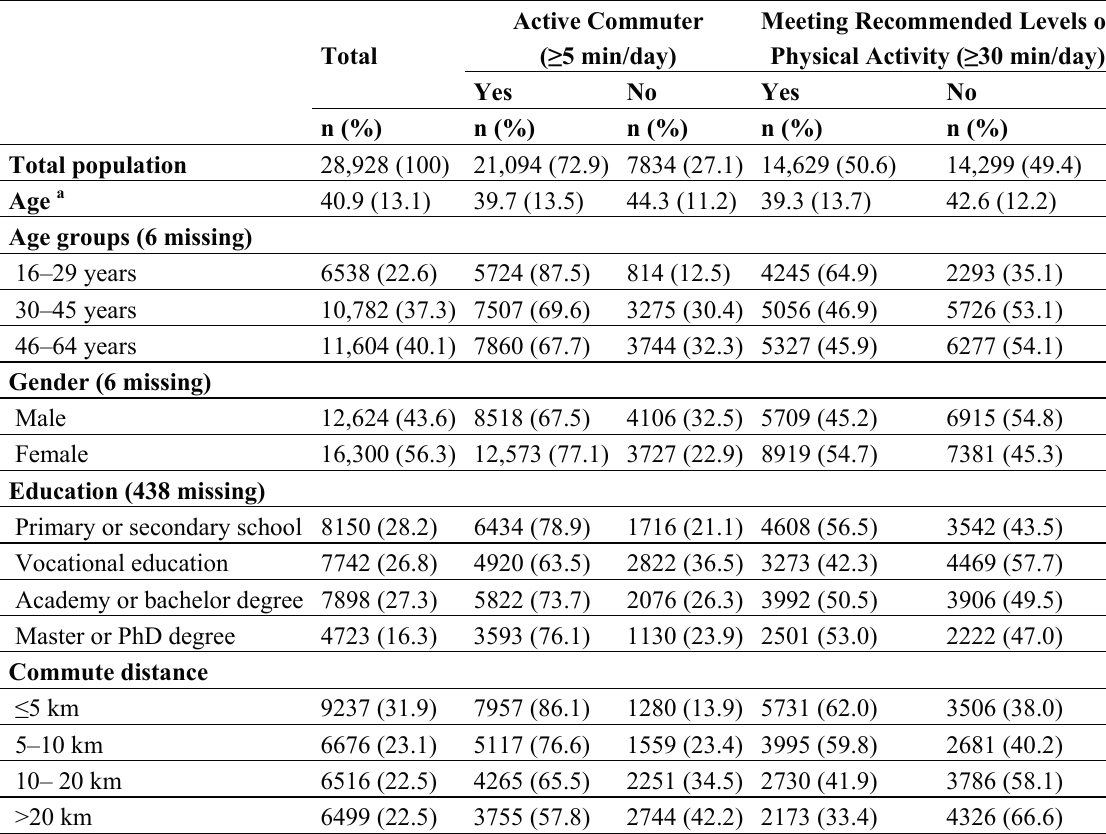
Table 2. Descriptive statistics of study population demographics and distances to work by subgroups of active commuters ( ≥ 5 min/day) (yes/no) and meeting recommendations of physical activity (yes/no).